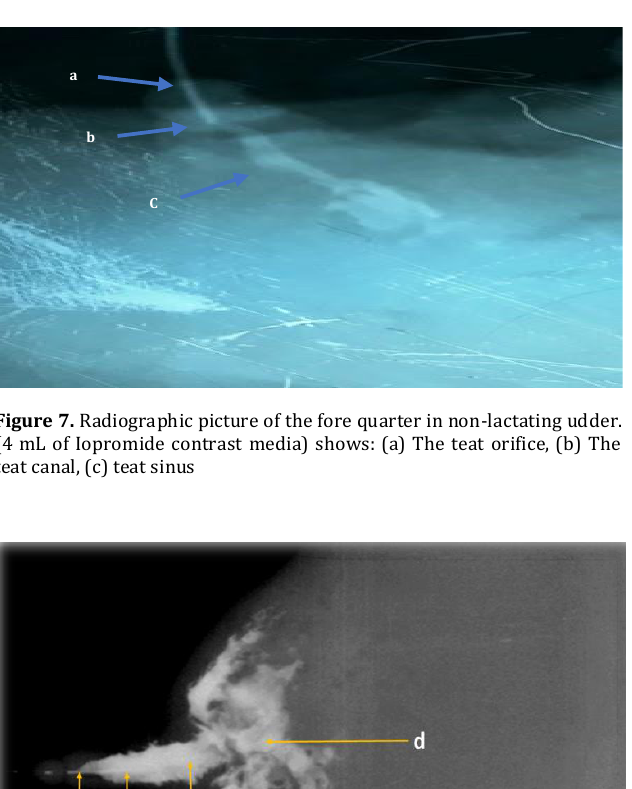
Figure 4. Photograph of Udder of local Iraqi cow with injected blood vessels shows: (a) External pudendal artery, (b) Branch of supramammary lymph node, (c) Supramammary lymph node, (d) Caudal mammary artery, (e) Cranial mammary artery